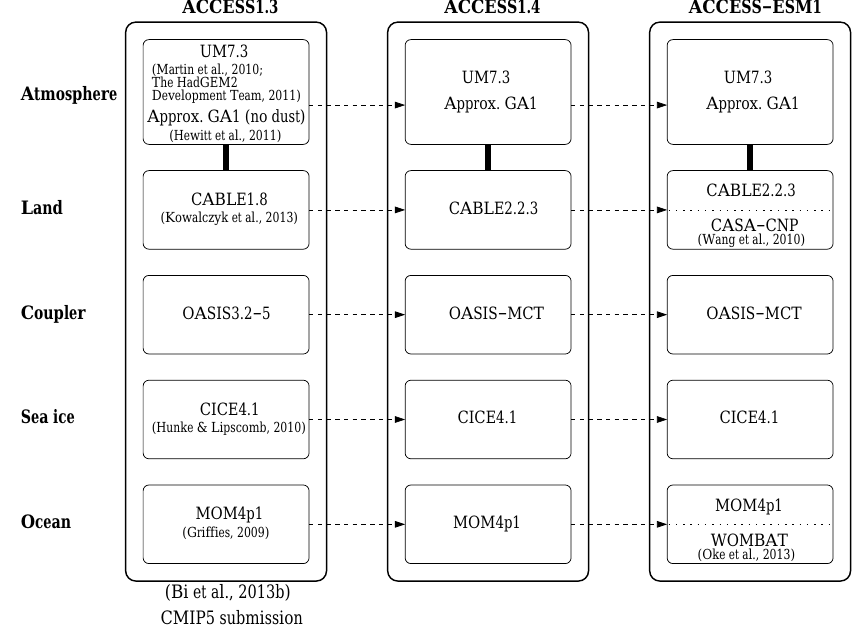
Figure 1. Schematic showing the different component models of ACCESS-ESM1 and the ACCESS versions on which it is